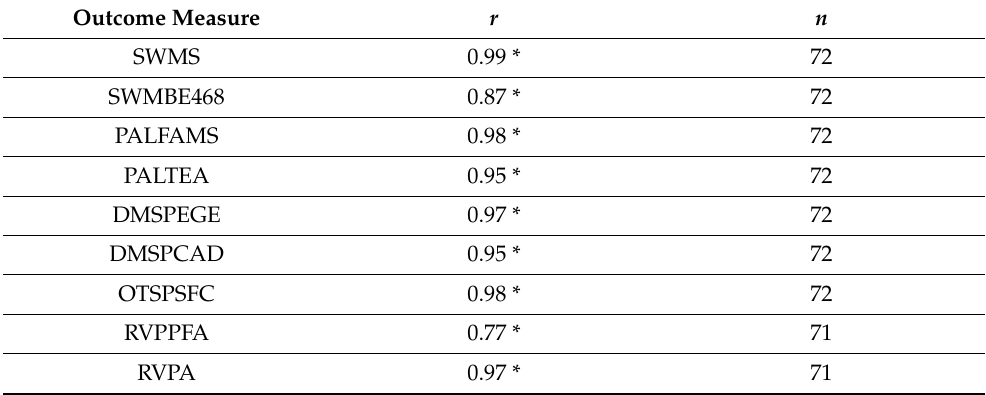
Table A2. Pearson correlations between CANTAB outcome raw scores and their own corresponding normative